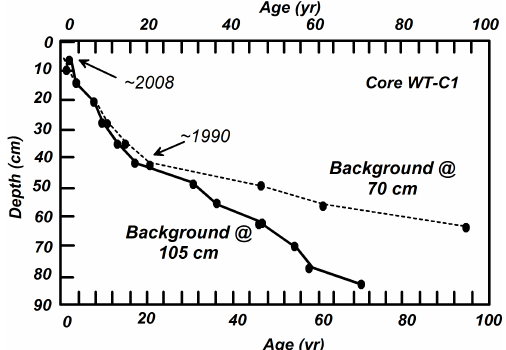
Fig. 9. Estimated age of the sediments in Core WT-C1 as deter- mined by 210 Pb analysis. The slope of the line in age-depth plot rep- resents the sedimentation rate. Sedimentation rates increase above 41.2cm, or after about